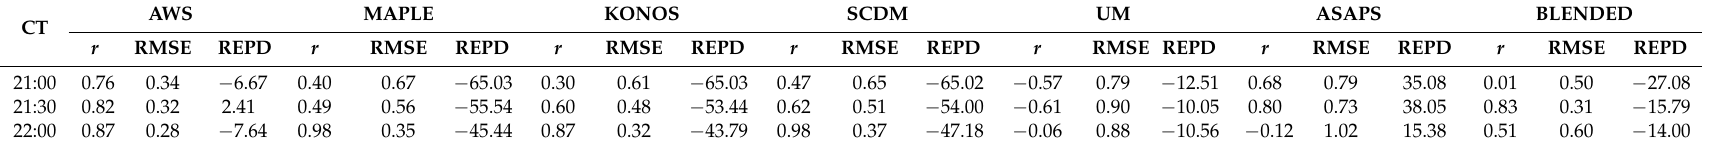
Table 2. Evaluation results for simulated water depth using various QPF products (Case 2) in terms of correlation coefficient ( r ), relative error of peak depth (REPD), and root mean square error (RMSE) by current time (CT).